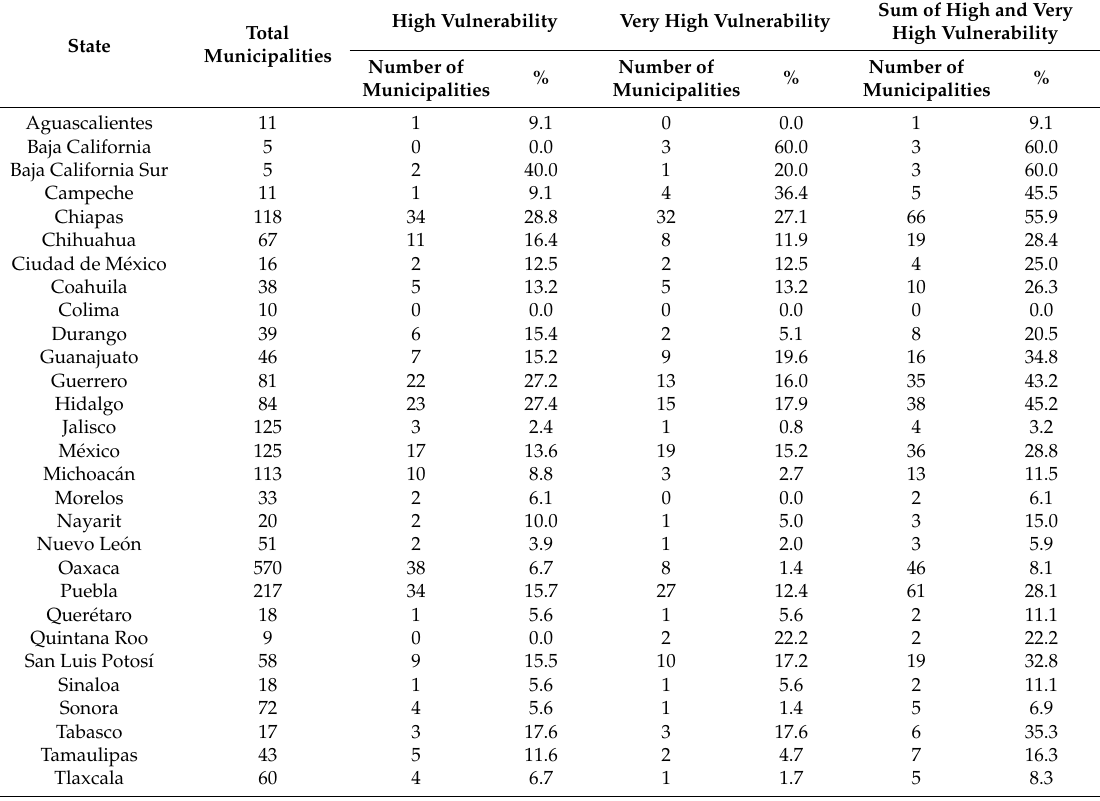
Table A3. Economic vulnerability. Number of municipalities by state and percentages of municipalities with high and very high economic vulnerability by